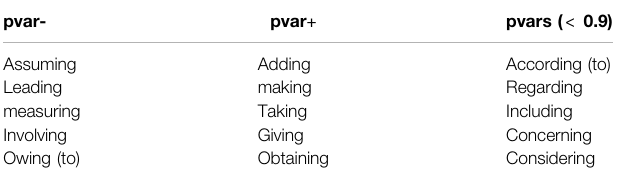
TABLE3| ParadigmaticVariabilityofVVGs.Top5withpvar-(left);top5withpvar+ (middle); selected 5 with pvars